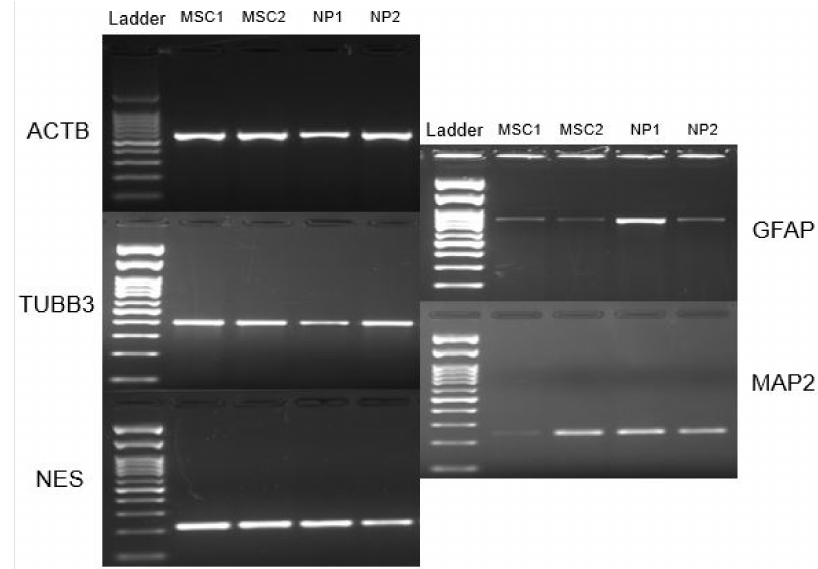
Figure 9. RT-PCR of neurospheres. Note: MSC, and Neural precursors